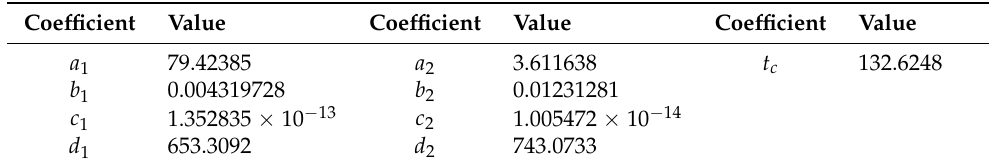
Table 1. Coefficient values of the Double-Debye function for calculating the frequency- and temperature-dependent complex permittivity of water.